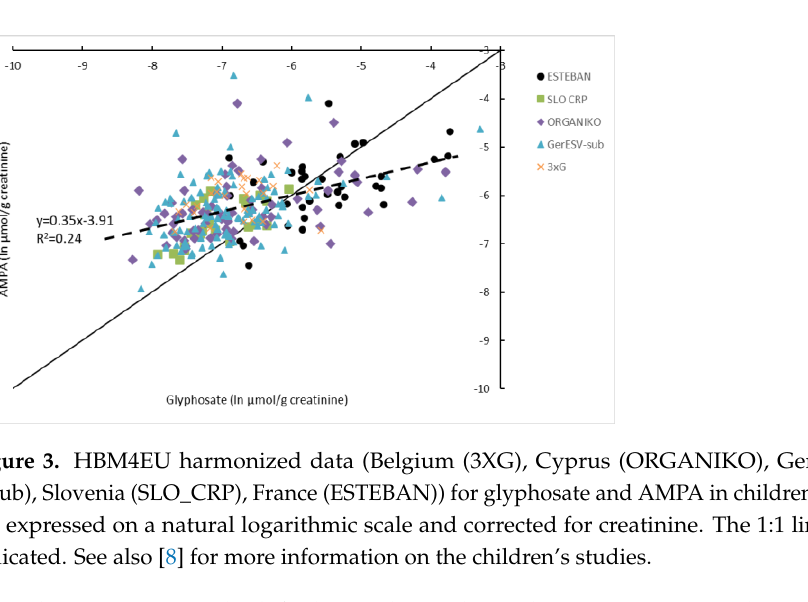
Table 4. Risk assessment of glyphosate (Gly) in adults of the general population based on HBM data (detection of Gly and AMPA with mass spectrometry).